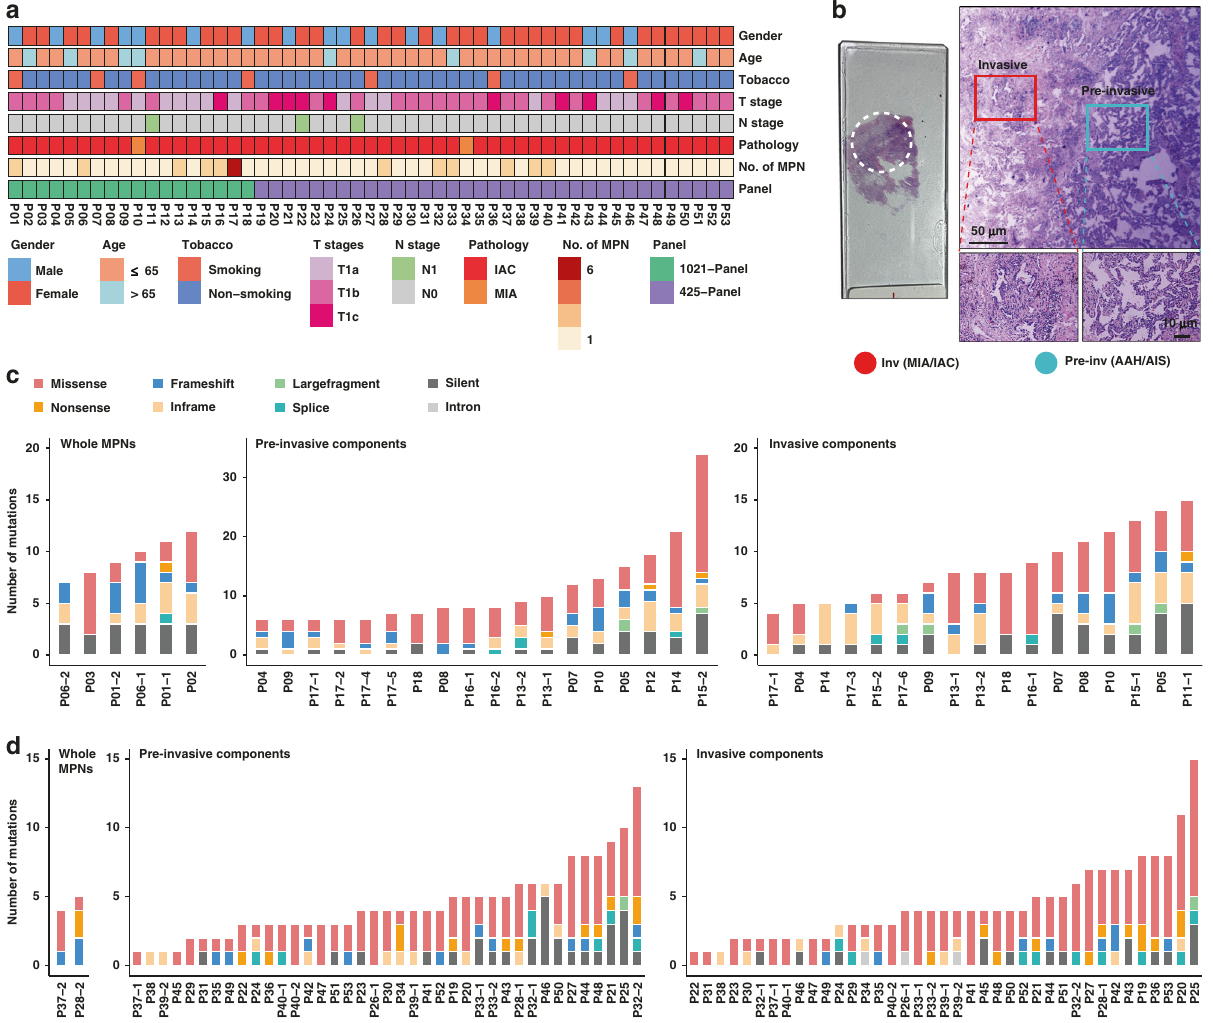
Fig. 1 Clinicopathological characteristics and genomic sequencing of micro-dissected MPNs. a Clinicopathologic characteristics of the included 53 T1 stage LUAD patients. b Micro-dissection was performed to separate pre-invasive and invasive components within MPNs. c , d Number and type of somatic mutations detected in 6 whole MPNs and 35 micro-dissected MPN components of the cases using 1021-panel (Phase 1; c ), and somatic mutations detected in 2 whole MPNs and 78 micro-dissected MPN components of the cases using 425-panel (Phase 2; d ). Inv Invasive, Pre-Inv pre-invasive, AAH atypical adenomatous hyperplasia, AIS adenocarcinoma in situ, MIA minimally invasive adenocarcinoma, IAC invasive